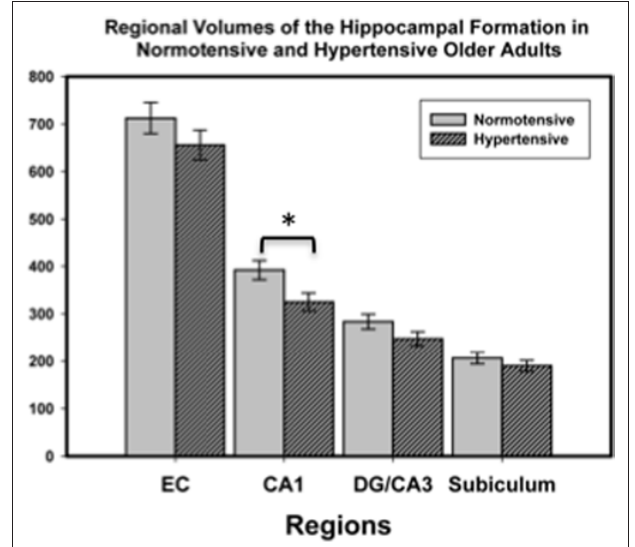
Figure 3 | Hippocampal subfield volumes in normotensive and hypertensive older adults. Group differences in volume were reliable only for subfield CA1-2. Volumes were adjusted for intracranial volume (ICV) as detailed in the text. The bars represent SE of the mean.